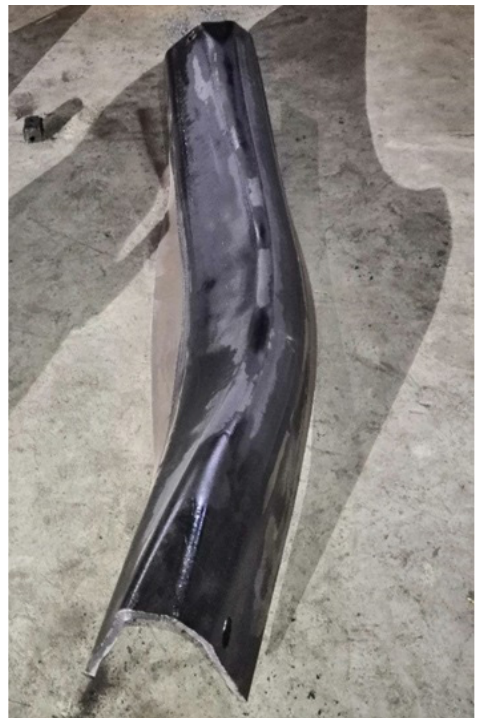
Figure 16. The formed V-shaped